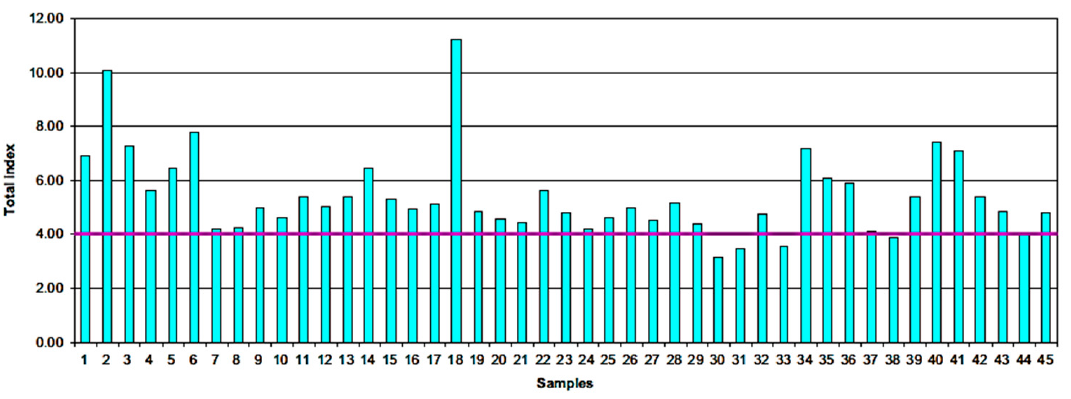
Figure 3. Total index for PAH source identification in indoor dust sample. Purple line indicates high temperature sources (Total index< 4) from low temperature sources (Total index >